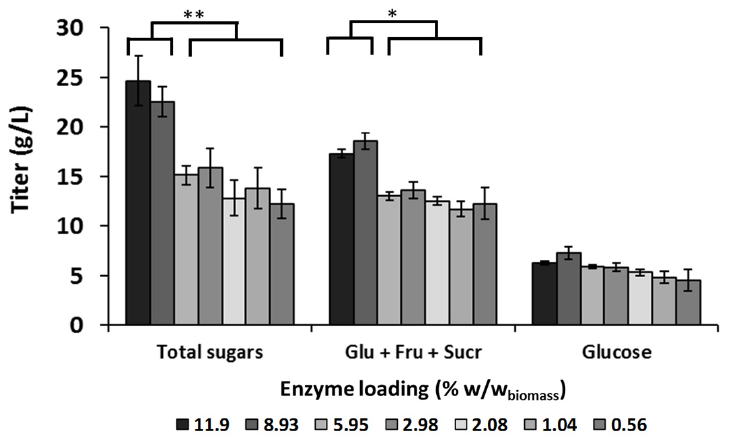
Figure 1. Sugar release from 15% ( w / v ) of Camelina meal by NS22119 enzymatic cocktail. The hydrolysis was performed at different loadings, and sugars released are shown in terms of total amount, intended as sum of sucrose, glucose, fructose, arabinose and galacturonic acid (first set of bars, from the left); the sum of sucrose, glucose and fructose (central set of bars); and sole glucose (right bars). Values are the means of three independent experiments. ** p < 0.02, * p < 0.05.